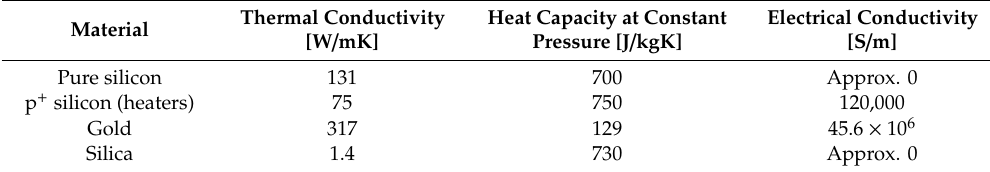
Table 1. Material parameters used in our numerical simulations.